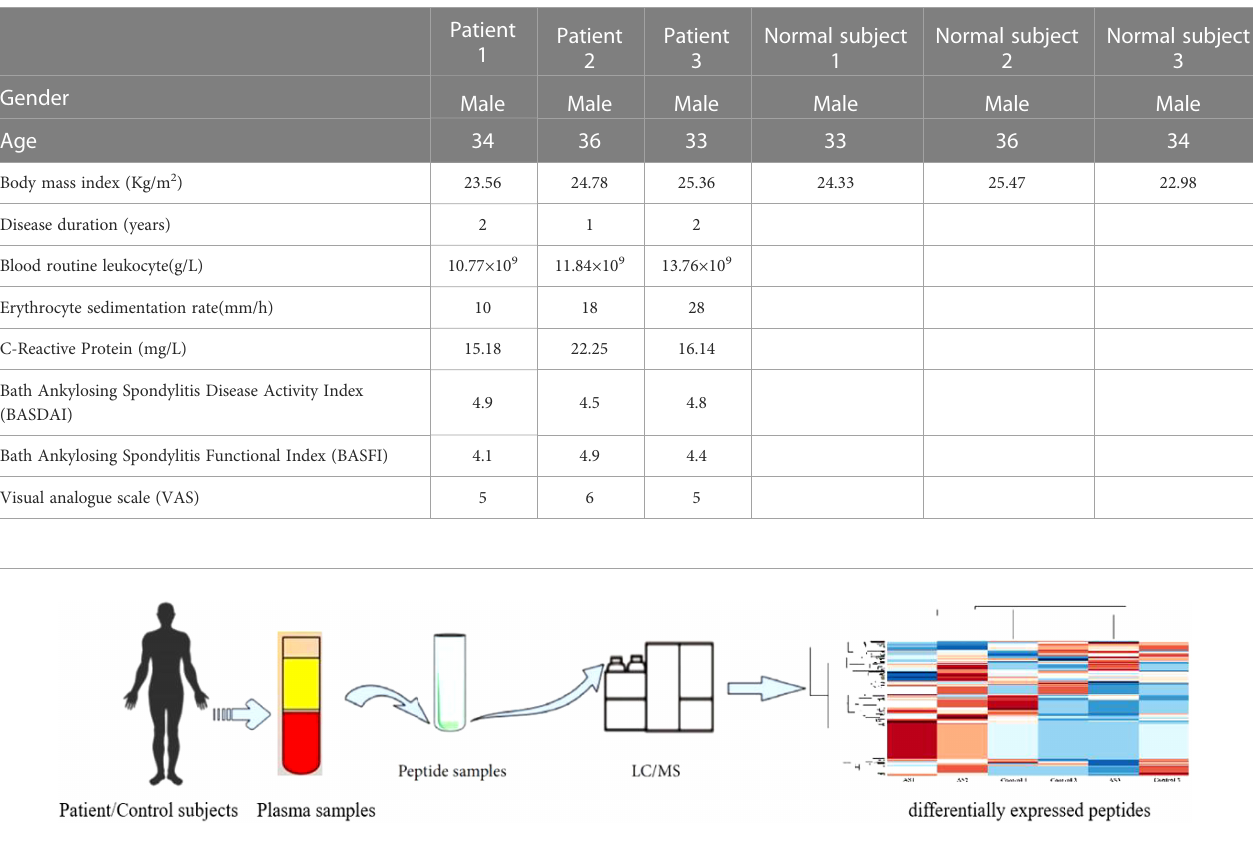
TABLE 1 The clinical characteristics of the subjects.